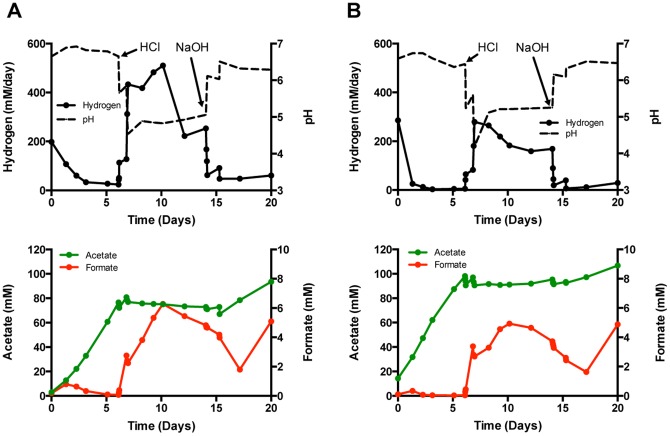
Effect of titration on production.Response of the electrosynthetic microbiome to the addition of HCl to reduce the pH, followed by titration with NaOH to re-establish near neutral pH. Reactors 4 and 5 were poised at −600 mV vs. SHE in a phosphate buffered medium with NaBES present in catholyte and anolyte.